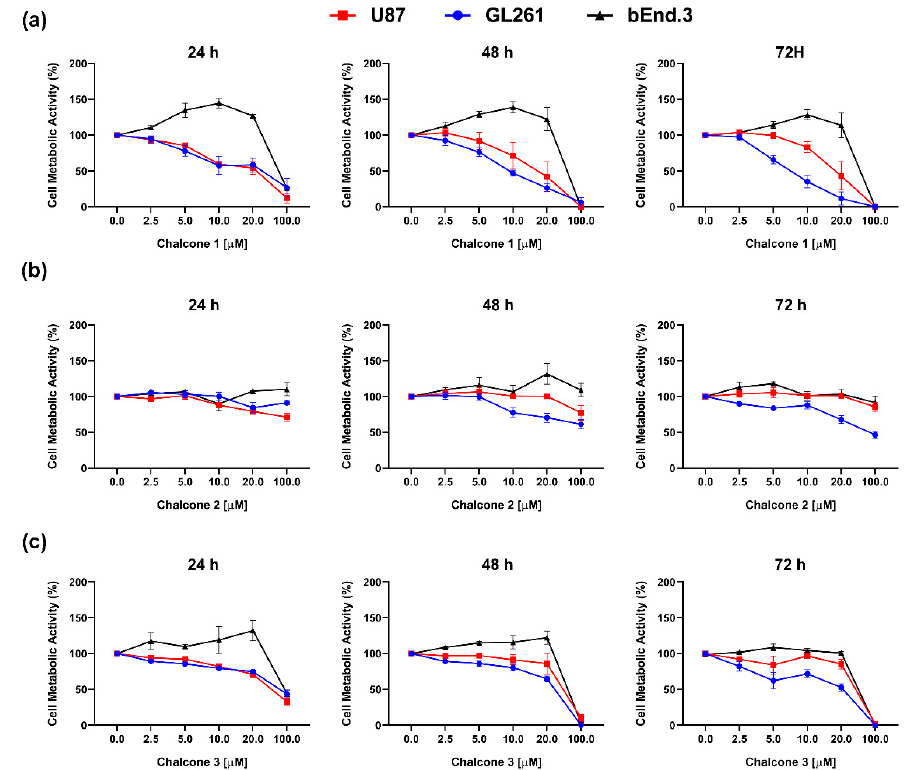
Figure 2. Cytotoxic effect of chalcone derivatives—Cell metabolic activity after treatment (24, 48, and 72 h) with chalcones 1 ( a ), 2 ( b ), and 3 ( c ) on GBM cell lines (U87 and GL261) and a brain endothelial cell line (bEnd.3) by MTS assay. Results are normalized to control (1% DMSO) and presented as mean ± SEM of three independent experiments.